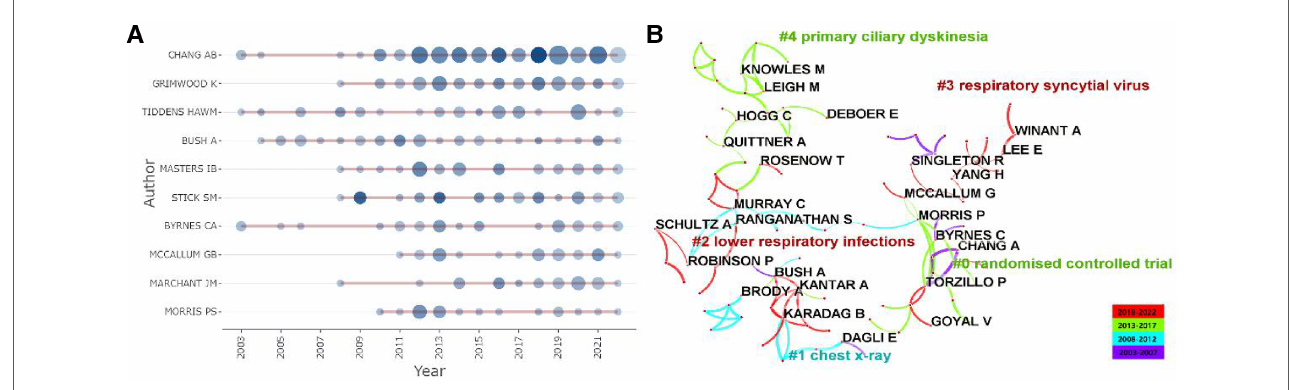
FIGURE 6 Analysis of authors related to pediatric bronchiectasis between 2003 and 2022. ( A ) Annual publication and citation count of top 10 authors. Node size represents the number of publications, and the shade of the color represents the number of citations. ( B ) Cooperation network map of authors, in which collaboration groups and the top fi ve keyword clusters are shown. Link thickness represents the cooperation strength.